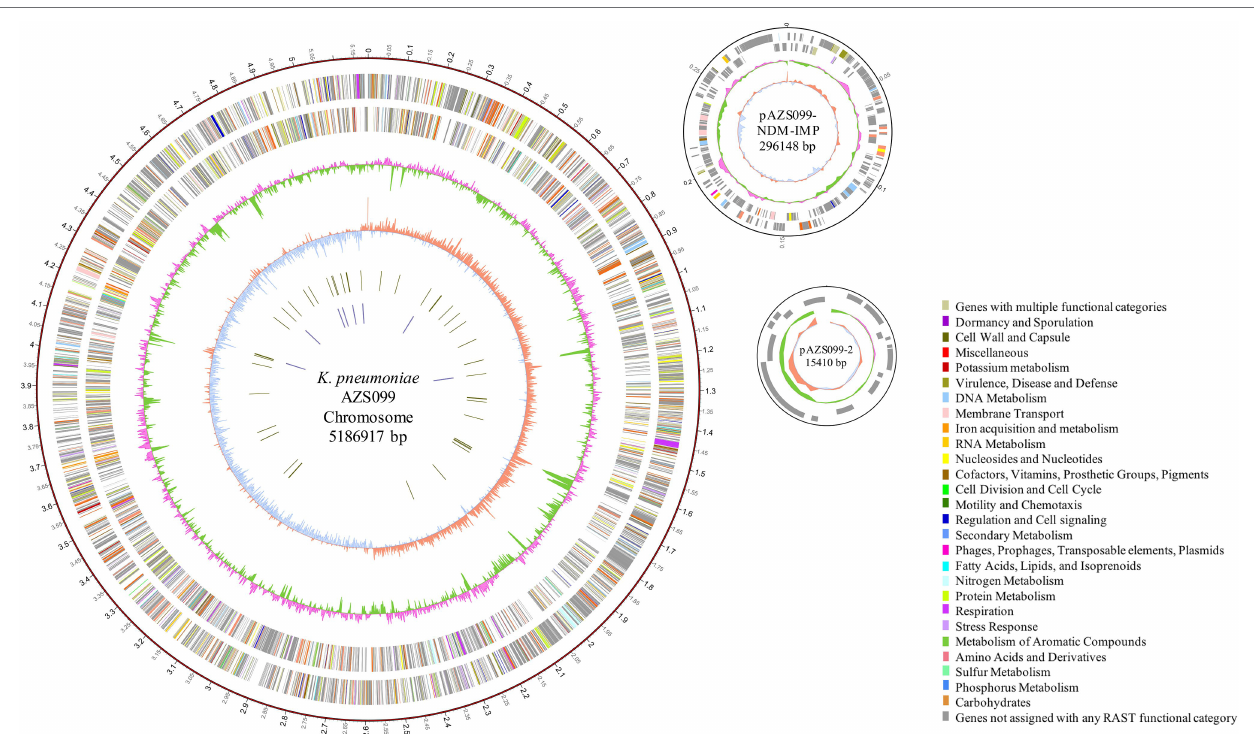
FIGURE 1 | Circular representation of AZS099 genome (chromosome and two plasmids). Circles are shown as follows (outside to inside): (1) A physical map scaled in megabases (Mb) from base 1 (the start of the putative replication origin); (2) coding sequences transcribed in a clockwise direction; (3) coding sequences transcribed in a counter-clockwise direction; (4) G + C content; (5) GC skew; (6) tRNA genes; and (7) rRNA genes. Genes displayed in (2) and (3) are color-coded according to different functional categories shown on the